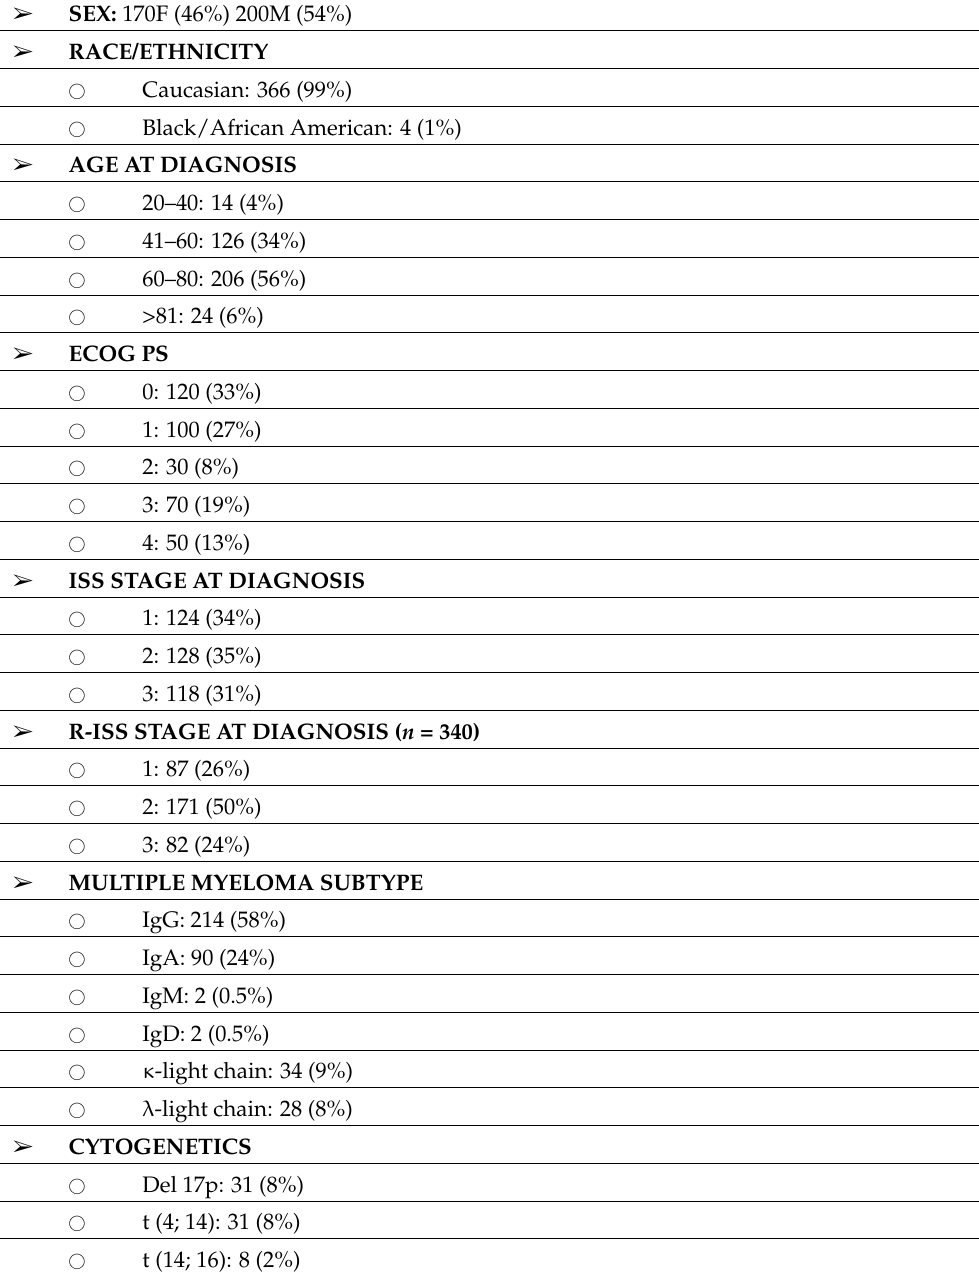
Table 1. Baseline patient characteristics ( n =